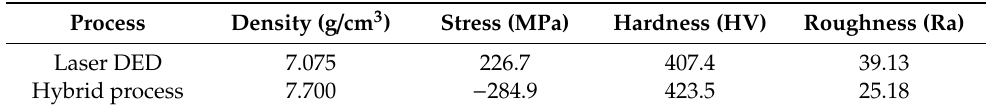
Figure 16. Forming samples under the optimized hybrid process. ( a ) Sample with peening and ( b ) sample without peening. Table 4. The properties of the